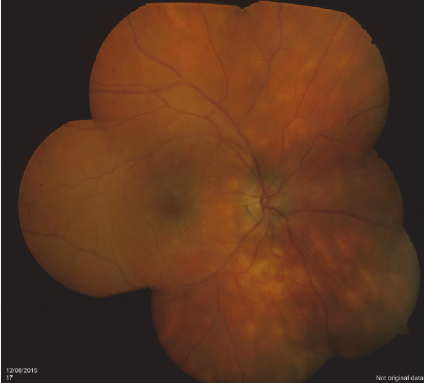
Figure 3: Colour fundus photo of the right eye revealing the white calcified astrocytoma and creamy retinal lesions in keeping with birdshot